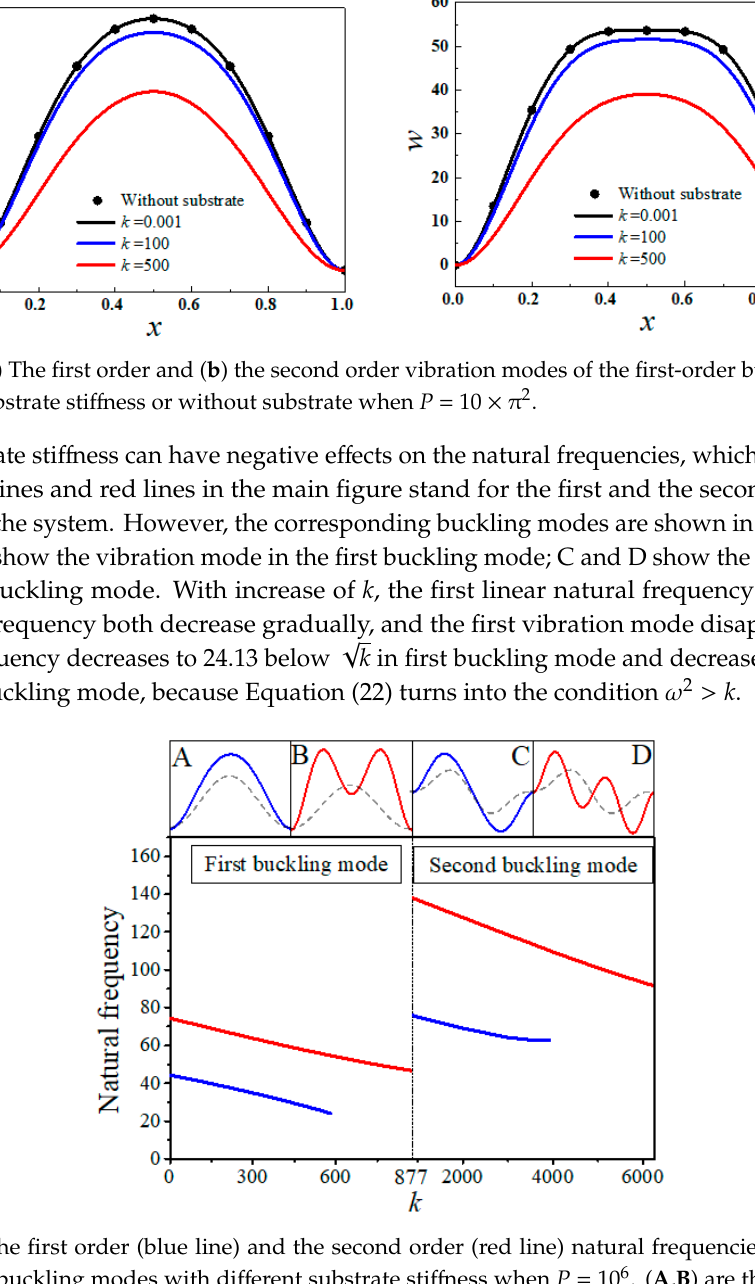
Figure 5. The first order (blue line) and the second order (red line) natural frequencies in the first two orders buckling modes with different substrate stiffness when P = 10 6 . ( A , B ) are the first order (blue line) and the second order (red line) vibration modes in the first order buckling mode (dot line). ( C , D ) are the first order (blue line) and the second order (red line) vibration mode in the second order buckling mode (dot line).